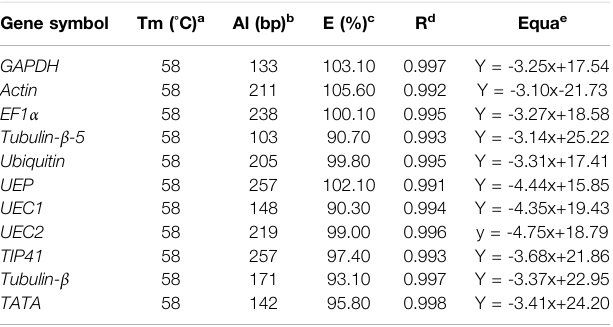
TABLE 3 | Primers used in this study and their ampli fi cation ef fi ciency and characteristics for eleven candidate reference genes in R. delavayi . Gene